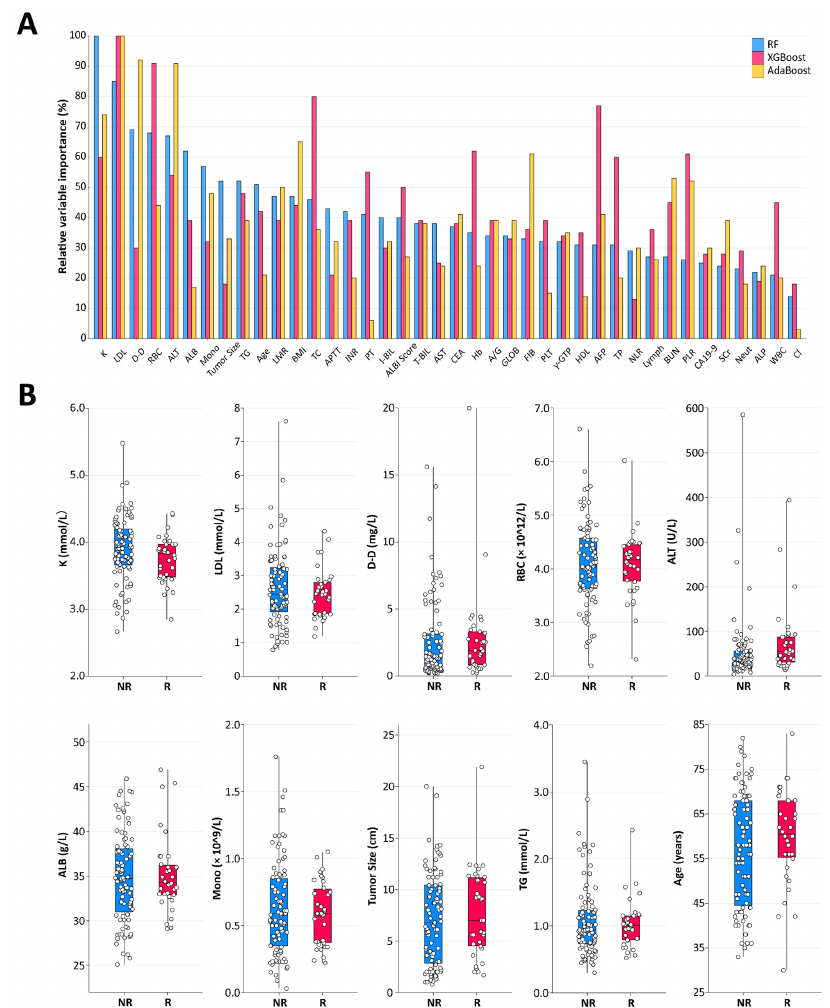
Figure 3. Importance matrix plot of the RF, AdaBoost, and XGBoost models. ( A ) Relative importance of the variables for segregation of the nonresponse group and response group calculated in the RF, AdaBoost, and XGBoost models. The variable importance is represented as a percentage of the highest value. ( B ) Box and jitter plots representing the distribution of the top 10 important features for distin- guishing nonresponse and response. LDL, low-density lipoprotein; D-D, d-dimer; RBC, red blood cell; ALT, alanine aminotransferase; ALB, albumin; Mono, monocyte; TG, triglyceride; LMR, lymphocyte monocyte ratio; BMI, body mass index; TC, total cholesterol; APTT, activated partial thromboplastin time; INR, international normalized ratio; PT, prothrombin time; I-BIL, indirect bilirubin; ALBI, albumin– bilirubin; T-BIL, total bilirubin; AST, aspartate aminotransferase; CEA, car-cinoembryonic antigen; Hb, hemoglobin; A/G, albumin/globulin; GLOB, globulin; FIB, fibrinogen; PLT, platelet; γ -GTP, γ -glutamyl transpeptidase; HDL, high-density lipoprotein; AFP, alpha fetoprotein; TP, total protein; NLR, neutrophil lymphocyte ratio; Lymph, lymphocyte; BUN, blood urea nitrogen; PLR, platelet lymphocyte ratio; CA19-9, carbohydrate antigen 19-9; Scr, serum creatinine; Neut, neutrophil; ALP, alkaline phosphatase; WBC, white blood cell; NR, nonresponse; R,